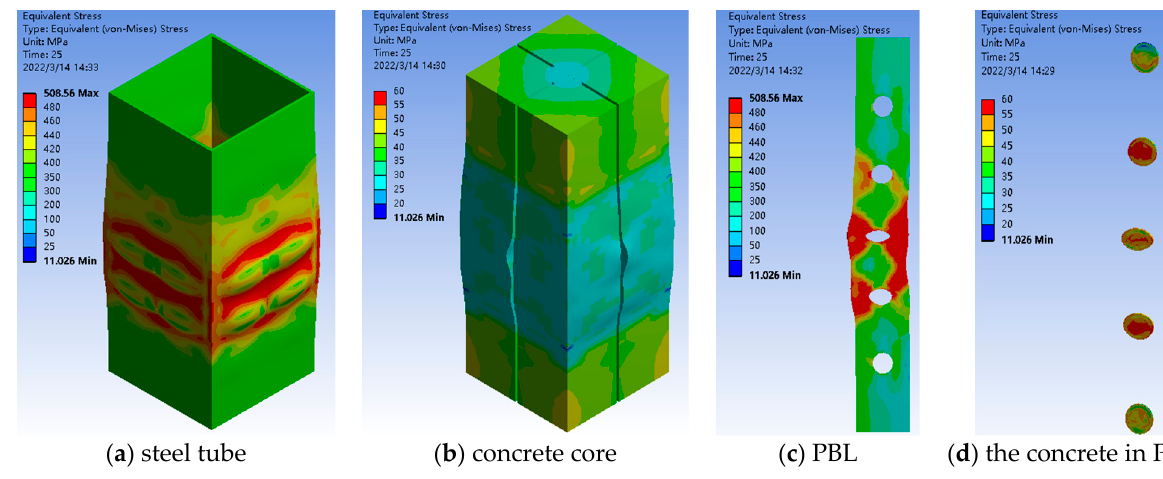
Figure 8. Failure mode and the equivalent stress of Type A.